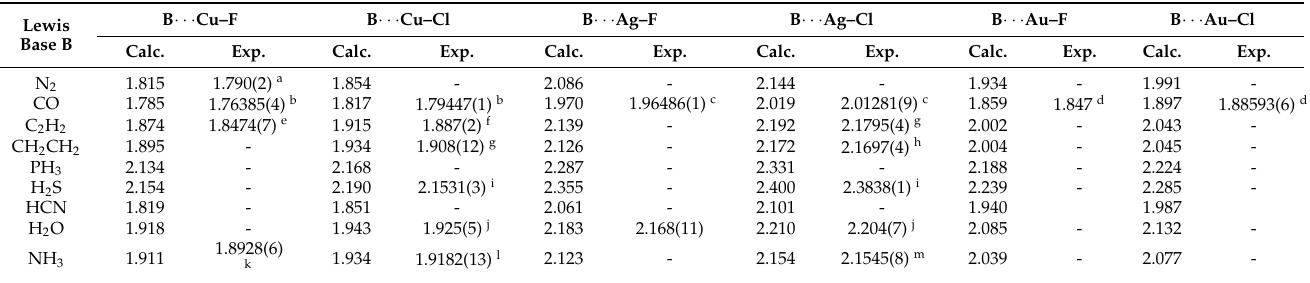
Table 3. Comparison of calculated and observed intermolecular distances r (Z · · · M)/Å in complexes B · · · M–X, where Z is the acceptor atom/centre in the Lewis base B. Lewis Base